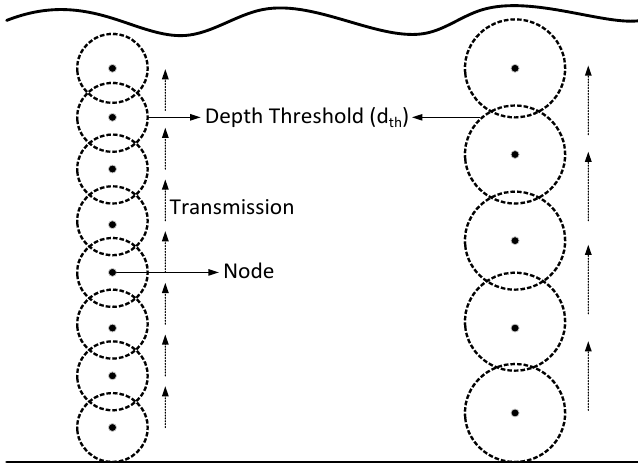
Figure 3. Varying depth threshold in